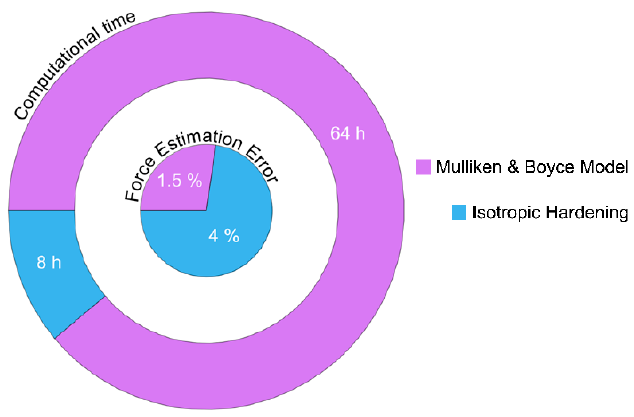
Figure 11. Mulliken and Boyce [20] material vs. the proposed elastoplastic isotropic hardening approach in PVC sheets regarding computational time and maximum F z estimation error.